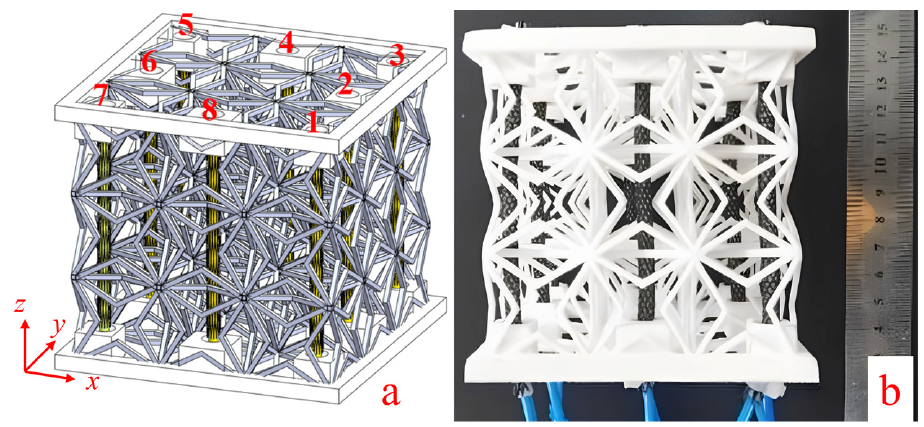
Figure 11. 3D ZPR actuation scheme. ( a ) Concept, ( b ) Prototype.